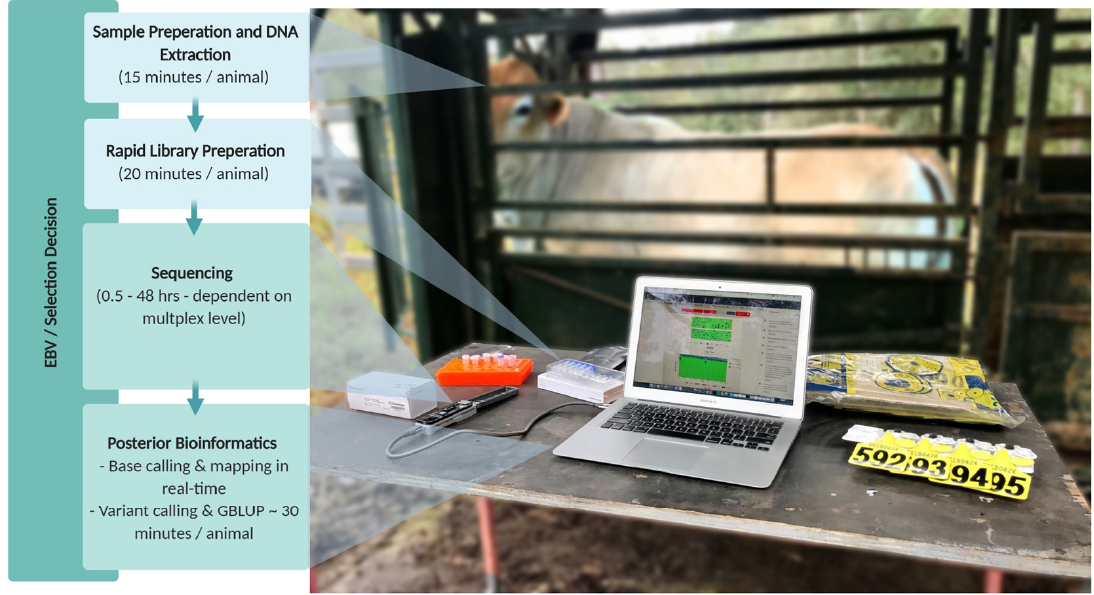
Figure 3. On-site genotyping of a brahman heifer in Queensland using the MinION. With multiplexing a mob of cattle could be genotyped overnight using this pipeline and selection decisions made the following morning using genomic breeding